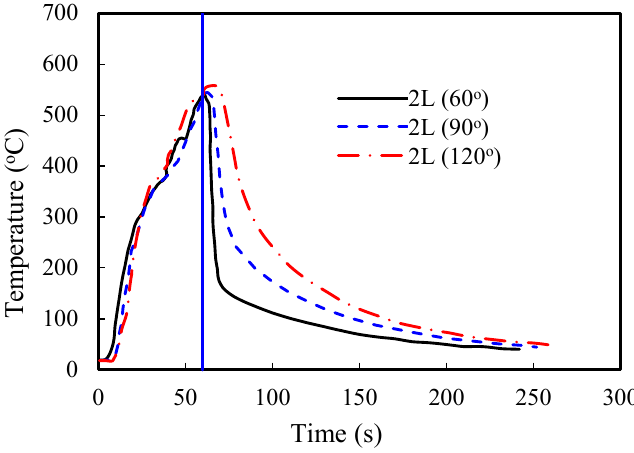
Figure 20. Time vs. temperature for different water mist nozzle spray angles [20].